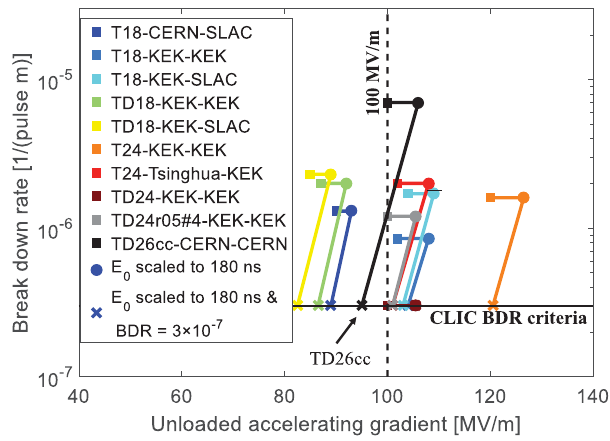
FIG. 3. High power tests on CLIC accelerating structure